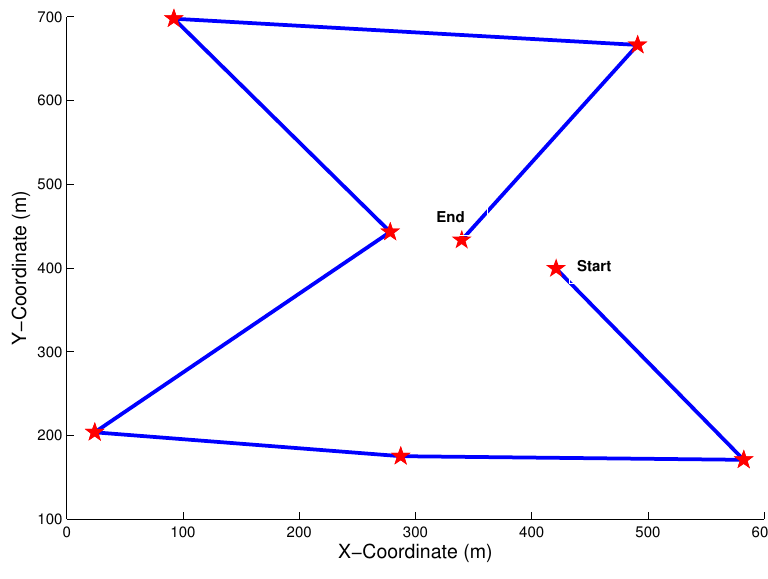
Figure 10. UAV trajectory in one